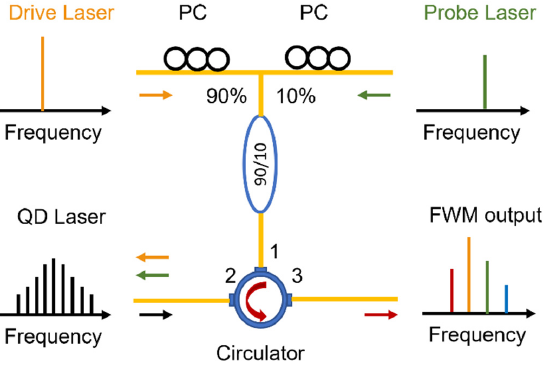
Figure 4. Experimental setup for nondegenerate four-wave mixing experiments. PC, polarization controller.